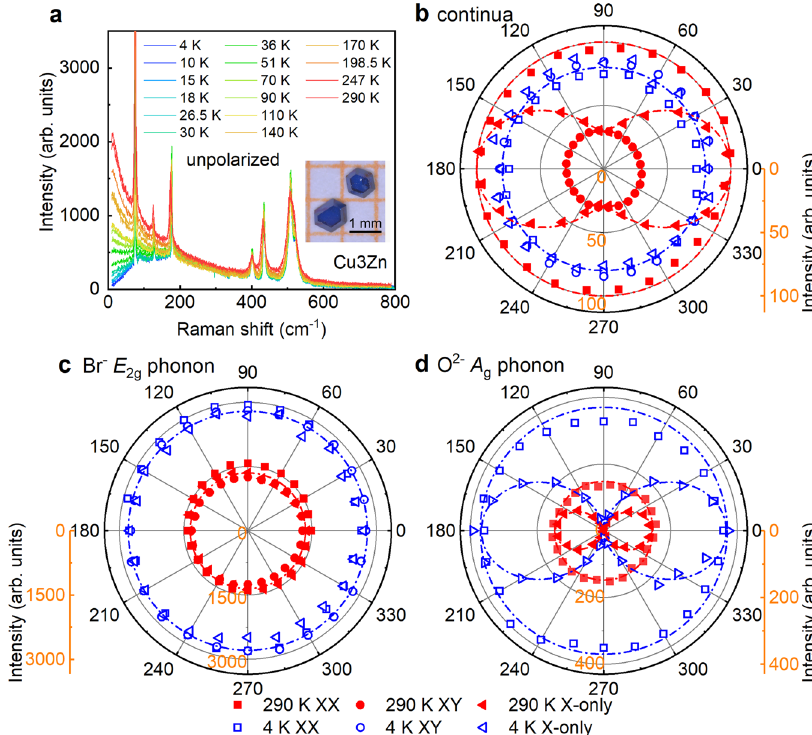
Fig. 2 Temperature dependent and ARPR spectra in Cu 3 Zn. a Temperature evolution of unpolarized Raman spectra in Cu 3 Zn. The inset is the photo of single crystals. ARPR intensity for low-energy continua ( b ), the Br − E 2g phonon (75 cm − 1 ) ( c ), and the O 2 − A 1g phonon (429 cm − 1 ) ( d ). The dash-dotted lines are the corresponding theoretical curves based on the C 3 rotation